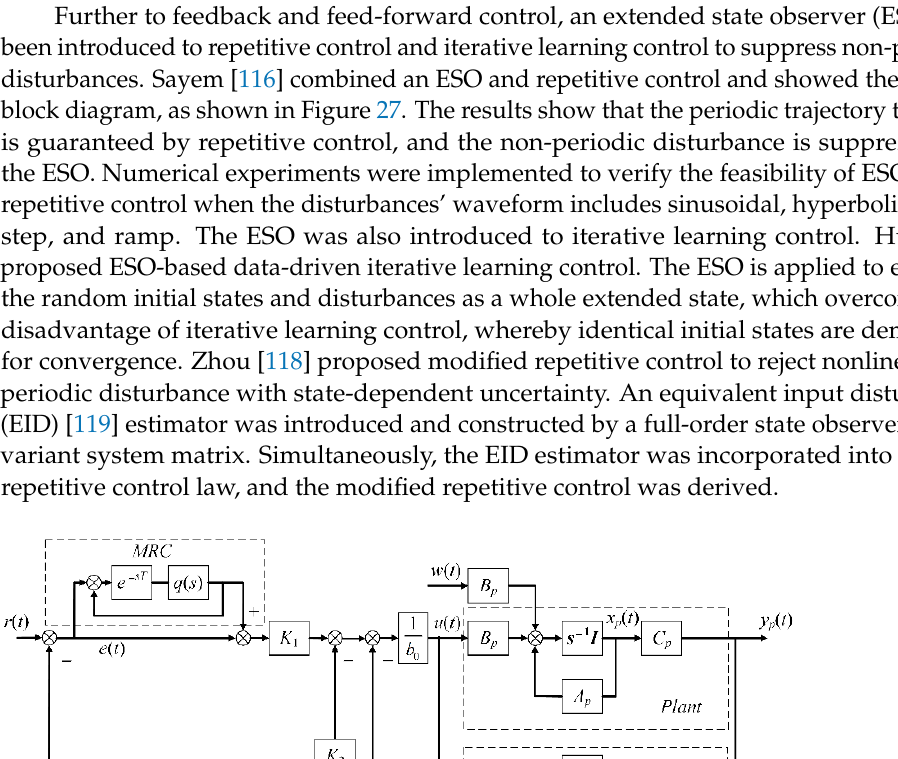
Figure 26. The tracking performance comparison between feed-forward and feedback model-free adaptive iterative learning control (FFMFAILC) and MFAILC, where FFMFAILC1 is the simulation results and FFMFAILC2 is the experimental results. Reprinted with permission from ref. [115]. Copyright 2019 IEEE.